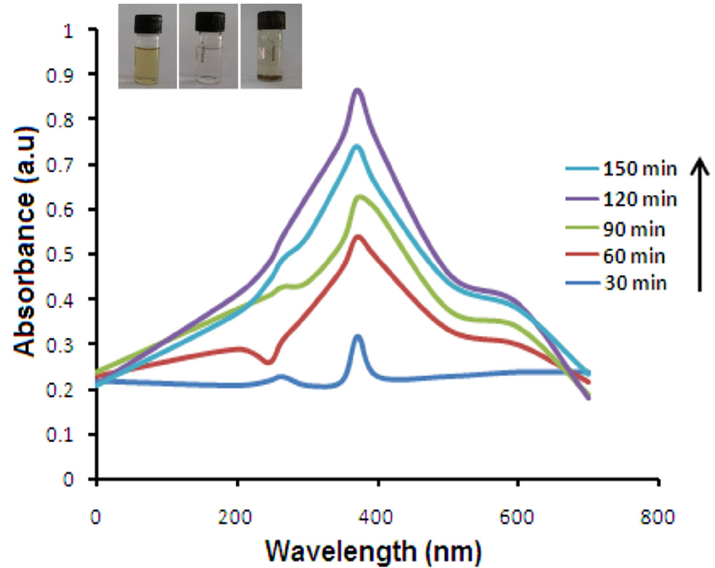
Figure 1. UV-Vis spectral analysis and color intensity of biosynthesized NPs at various time intervals of synthesized ZnO NPs at 120 min. The inset shows the color change from yellow to ruby-red in